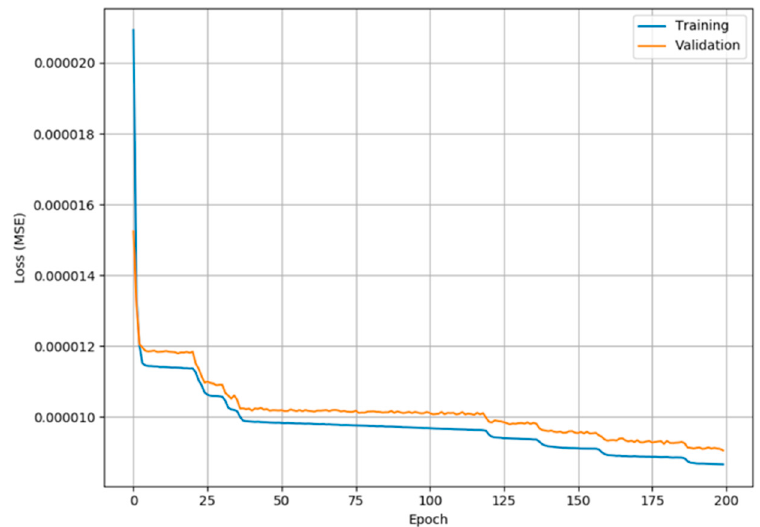
Figure 7. Loss function trend.